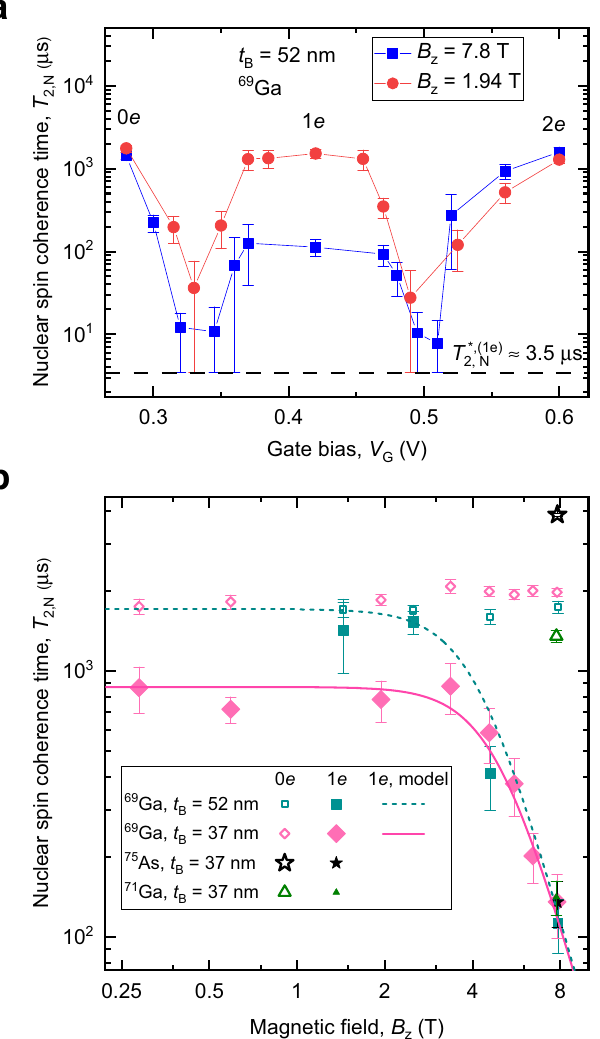
Fig. 2 Coherence time of the nuclear spins coupled to quantum dot electron spin qubit. a Gate bias ( V G ) dependence of the 69 Ga nuclear spin echo decay time T 2,N in the t B = 52 nm sample at B z = 1.94 T (circles) and B = 7.8T (squares). Solid lines are a guide to the eye. Resonant cotunneling z between QD and the Fermi reservoir leads to reduction of T 2,N down to dephasing time (cid:3) T (cid:4) ; ð 1 e Þ (dashed line), observed as dips at V G ≈ 0.33V 2 ; N and ≈ 0.5V, which separate the Coulomb blockade plateaus corresponding to stable QD charge states 0 e , 1 e, and 2 e . b Nuclear spin coherence in an empty QD ( T ð 0 e Þ , open symbols) and electron-charged QD ( T ð 1 e Þ solid 2 ; N 2 ; N symbols) measured as a function of magnetic fi eld B z for spin-3/2 isotopes in samples with different t B . Lines show T ð 1 e Þ of 69 Ga calculated according to 2 ; N the model of Eq. (1) for t B = 37nm (solid line) and t B = 52nm (dashed line) samples. Error bars are 95% con fi dence